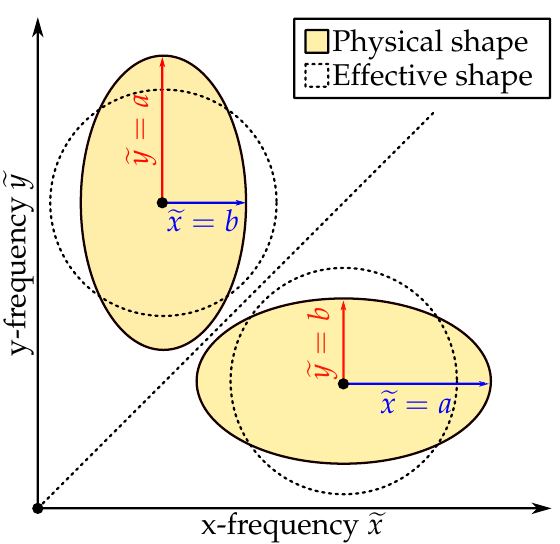
Figure 3. Comparison between feature shapes in the 2D frequency space and its projection onto the 1D effective frequency space.